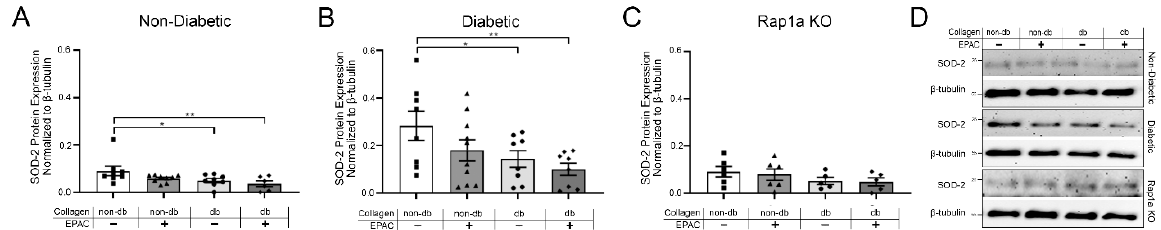
Figure 6. Treatment with EPAC and diabetic collagen caused decreased SOD-2 expression in cardiac fibroblasts. Isolated cardiac fibroblasts from ( A ) non-diabetic, ( B ) diabetic, and ( C ) Rap1a KO were cultured on non-diabetic or diabetic collagen and treated with EPAC (100 µM). Total protein was collected and expression of oxidative maker SOD-2 (25 kDa) was determined. SOD-2 protein expression was normalized to β -tubulin (55 kDa) and mean ± SEM are presented within the graphs ( n = 5–10). One-way ANOVA followed by a Fisher’s Least Significant Difference post hoc was used to determine significant differences (* p < 0.05 and ** p < 0.01). ( D ) Representative Western blot images are presented for SOD-2 expression.